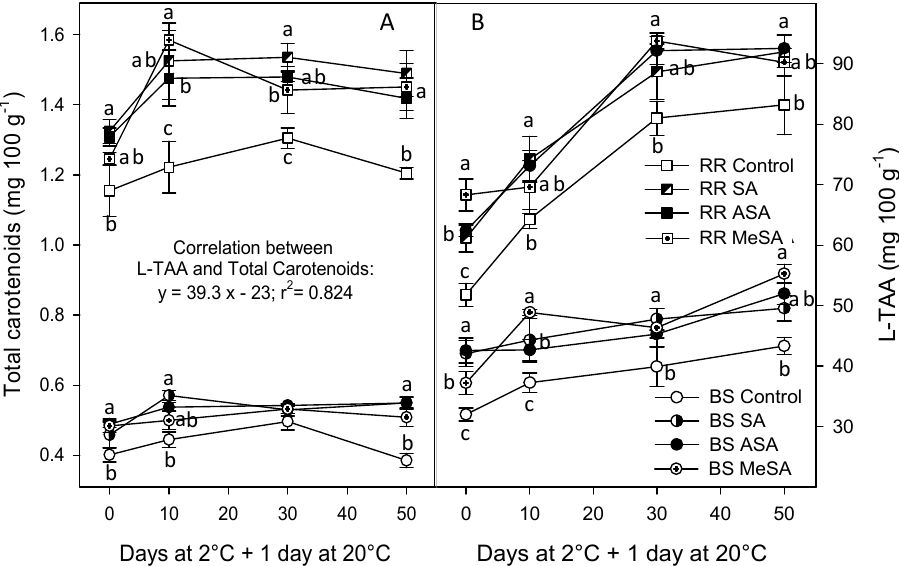
Figure 3. Total carotenoid concentration ( A ) and lipophilic antioxidant activity (L-TAA); ( B ), in “Black Splendor” (BS) and “Royal Rosa” (RR) plums from control and salicylic acid (SA)-, acetyl salicylic acid (ASA)-, and methyl salicylic acid (MeSA)-treated trees at harvest and along storage at 2 ° C + 1 day at 20 ° C. Symbols for BS and RR control and treated plums are similar for figures A and B. Data are the mean ± SE of three replicates. Different lowercase letters show significant differences ( p < 0.05) among treatments for each sampling date and cultivar.